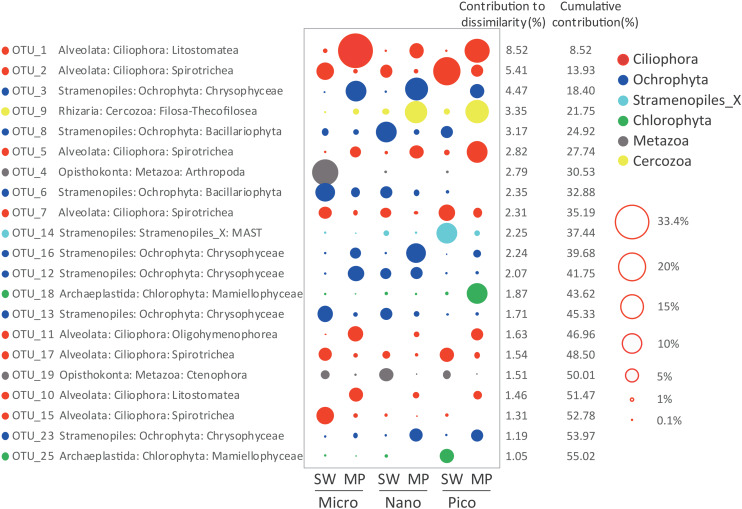
Taxonomic identities of the 21 ZOTUs that contributed most to community dissimilarities between sea water (SW) and melt ponds (MPs) with their relative contributions to community dissimilarities. The diameters of the circles are proportional to the abundances of the ZOTUs, with the size of the circle indicating the average abundance of each ZOTU at a given size of SW and MP groups.